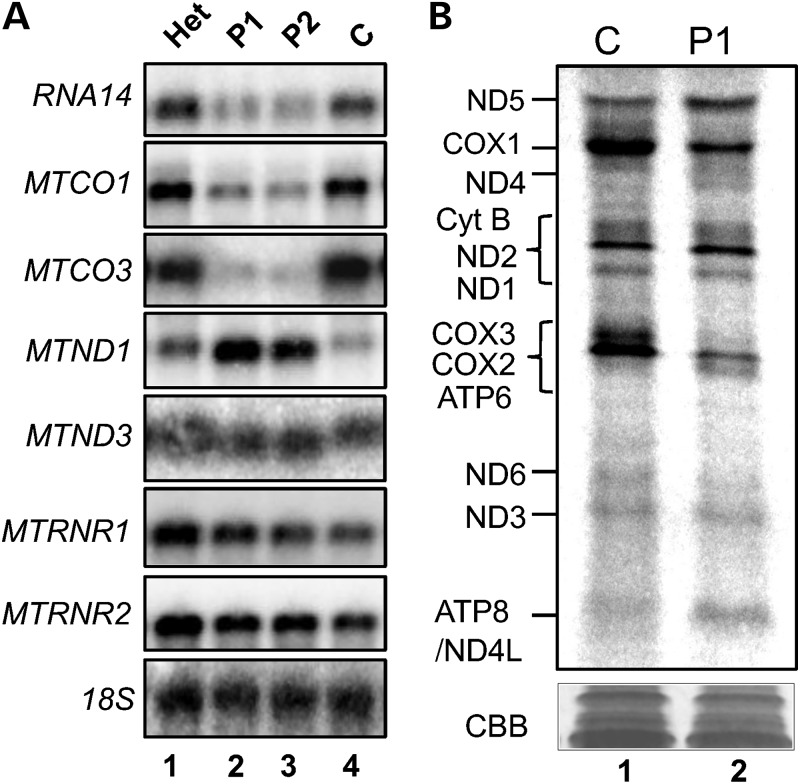
The p.N478D mutation in mtPAP affects steady-state levels and translatability of mtDNA-encoded transcripts. (A) RNA was isolated from control and patient fibroblasts, and steady-state levels of mitochondrial rRNA and mRNA were assessed by northern blotting (4 µg), using the probes indicated. A probe against the 18S rRNA transcript was used as a loading control. The blot is representative of data from three independent RNA isolations. (B) De novo protein synthesis of mitochondrially encoded proteins was analysed in control and patient fibroblasts. Cells were incubated with [35S]-methionine/cysteine for 1 h in the presence of the cytosolic translation inhibitor emetine dihydrochloride (100 µg/ml). Equal amounts of whole cell lysate (50 µg) were separated via 15–20% denaturing SDS–PAGE and translation products visualized by autoradiography. Individual polypeptides were designated by their mobility (21). The protein profiles are representative of data derived from three independent experiments.